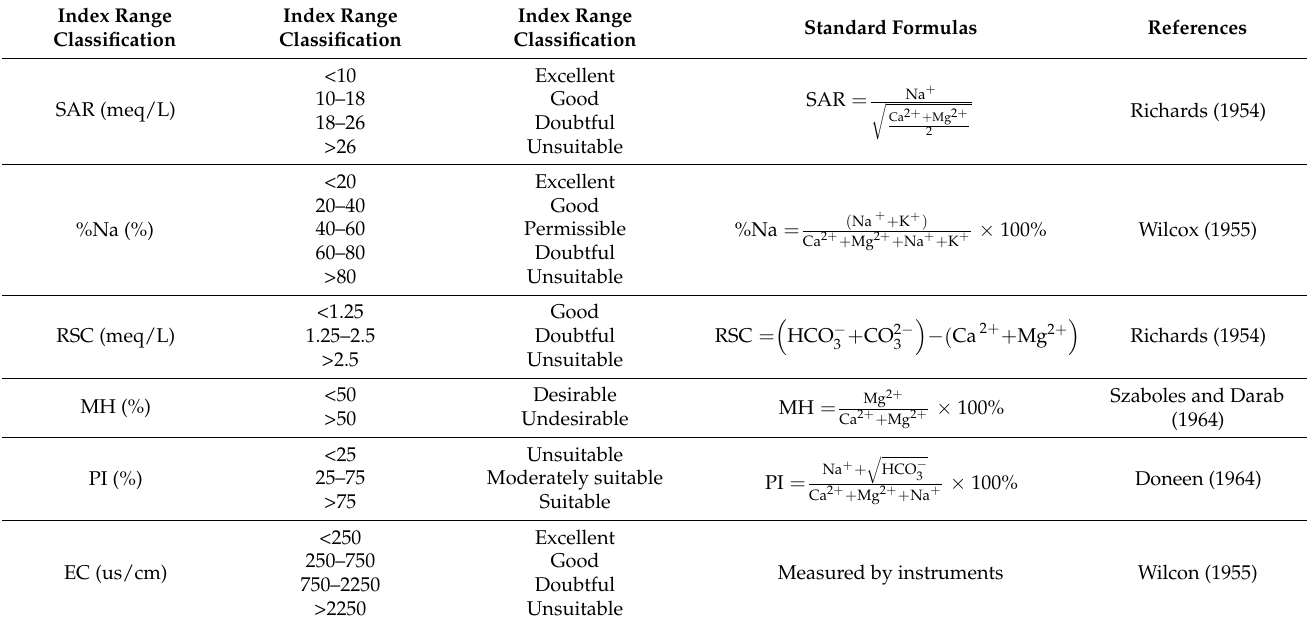
Table 1. Classification of groundwater suitability for agricultural